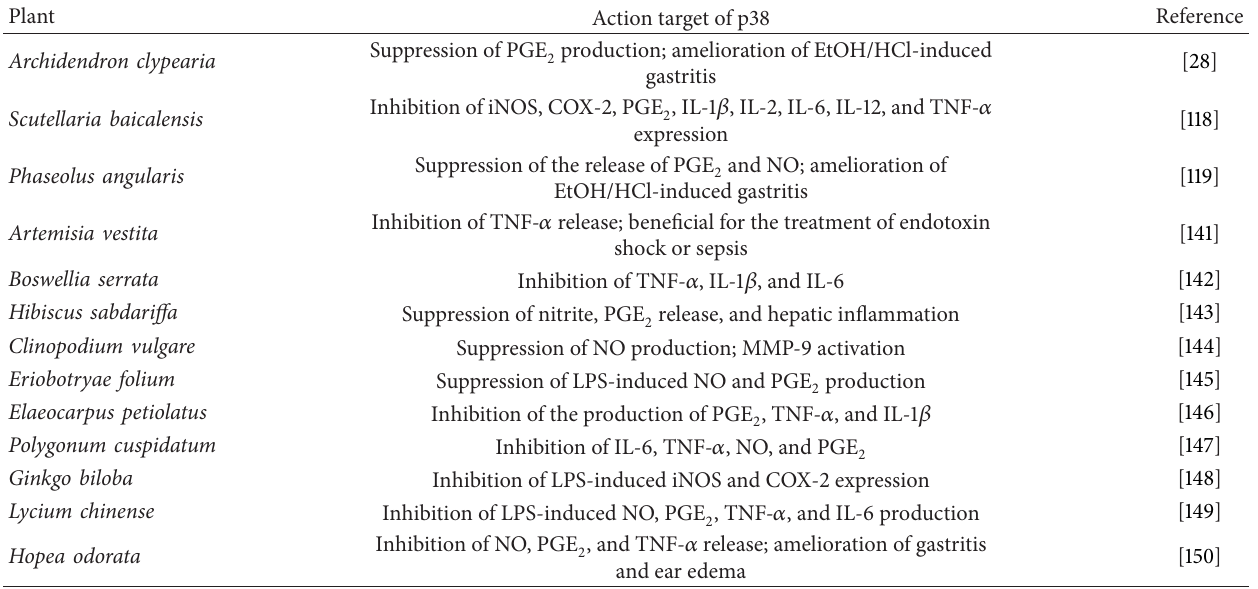
Table 2: Plant extracts that inhibit the p38 signaling in macrophages.